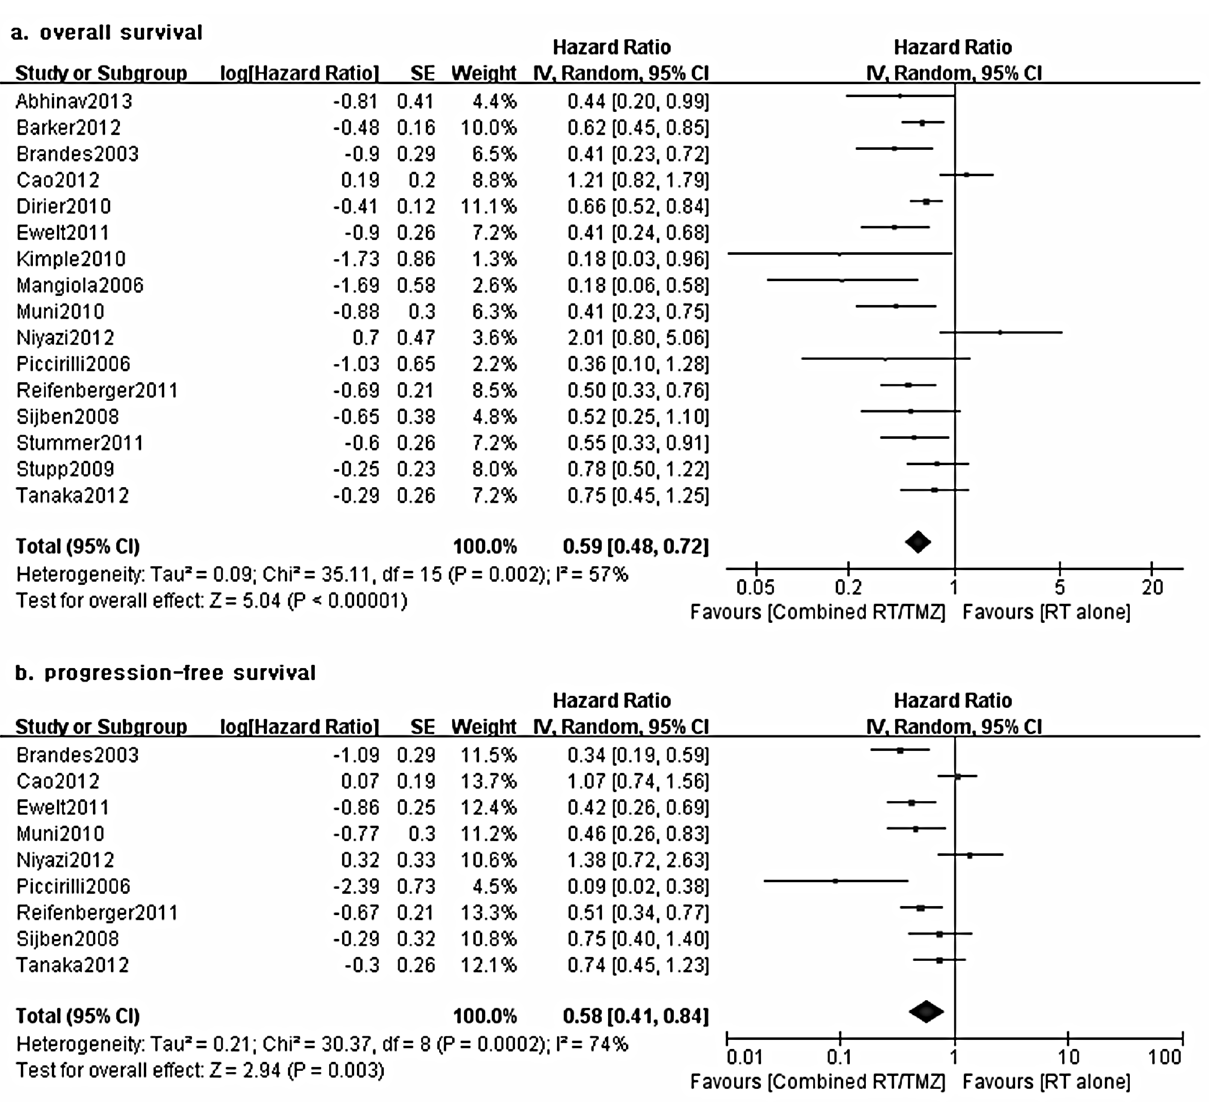
Figure 2. Forest plot of comparison: Combined RT/TMZ versus RT alone, outcome: a) overall survival; b) progression-free survival.